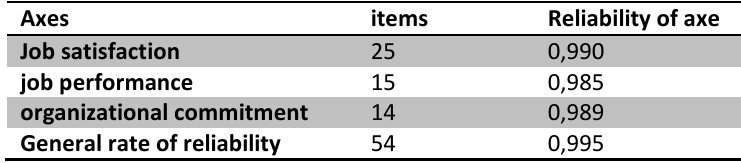
Table 1. Cranach alpha reliability and Validity of questionnaire Axes items